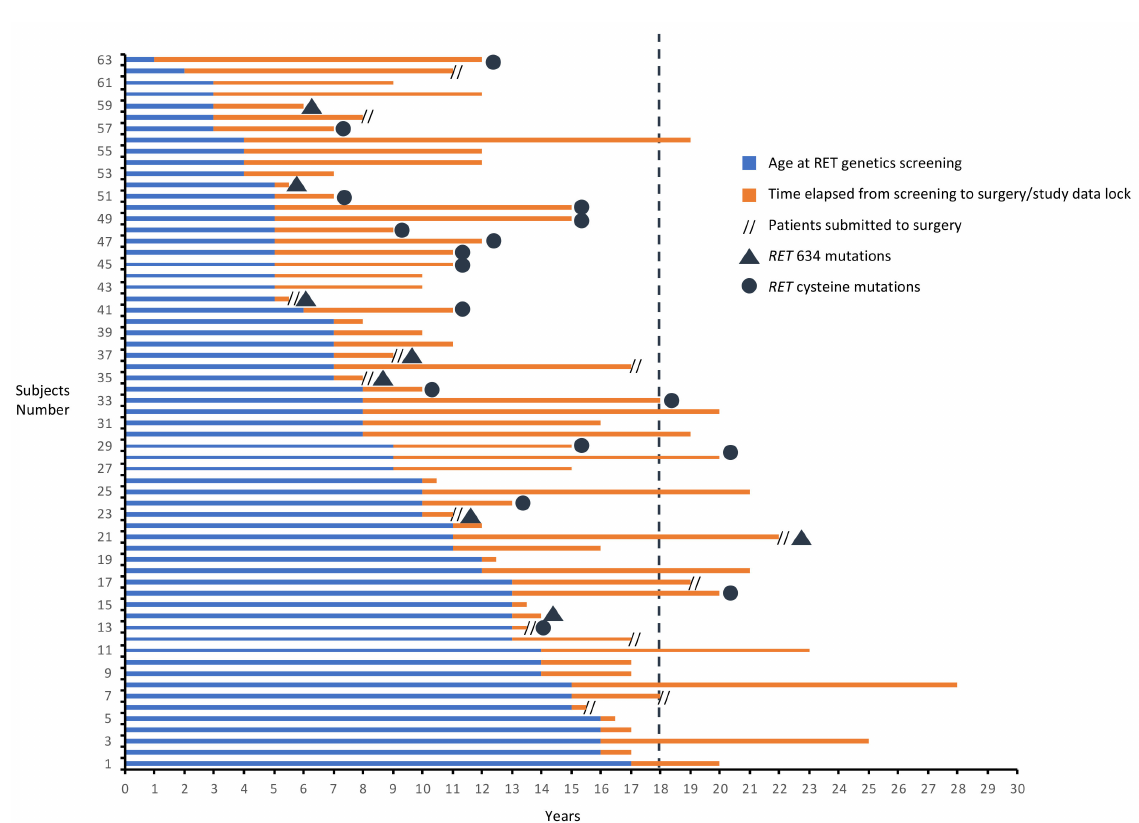
Figure 5. Genetic landscape, and duration of follow-up, of GCs younger than 18 at the time of RET genetic screening of Group A, B1 and